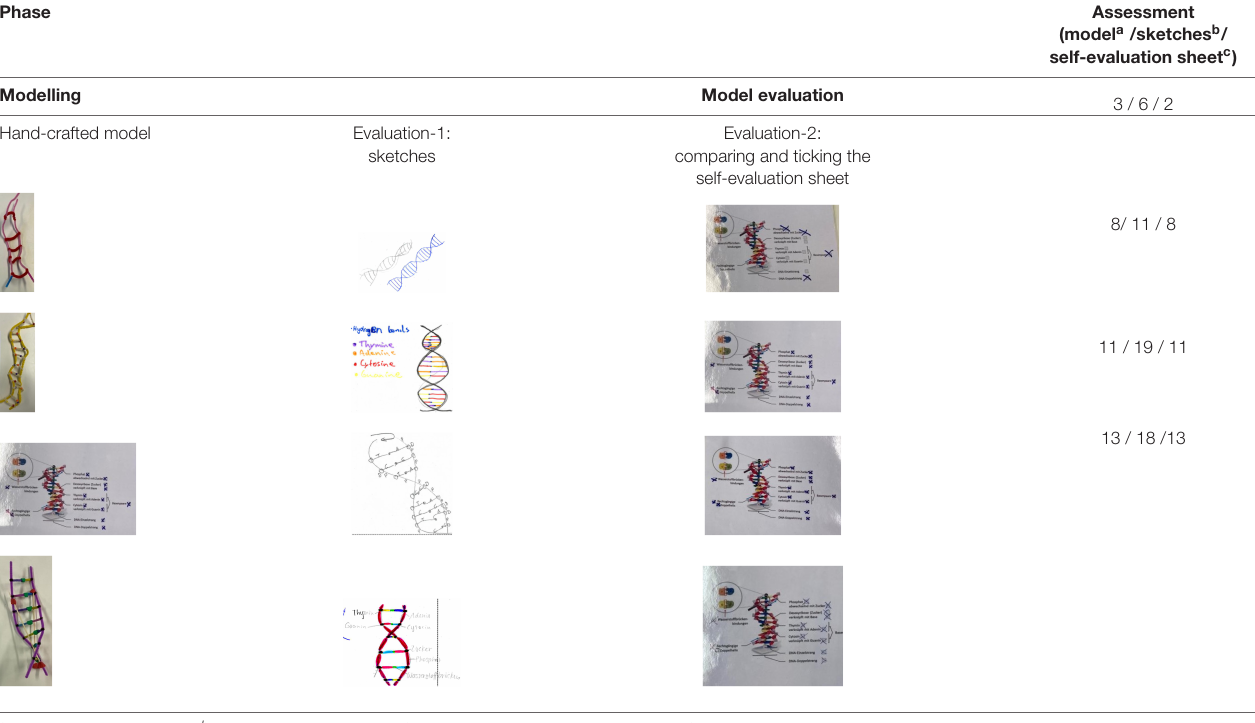
TABLE 2 | Assessment of students’ evaluation